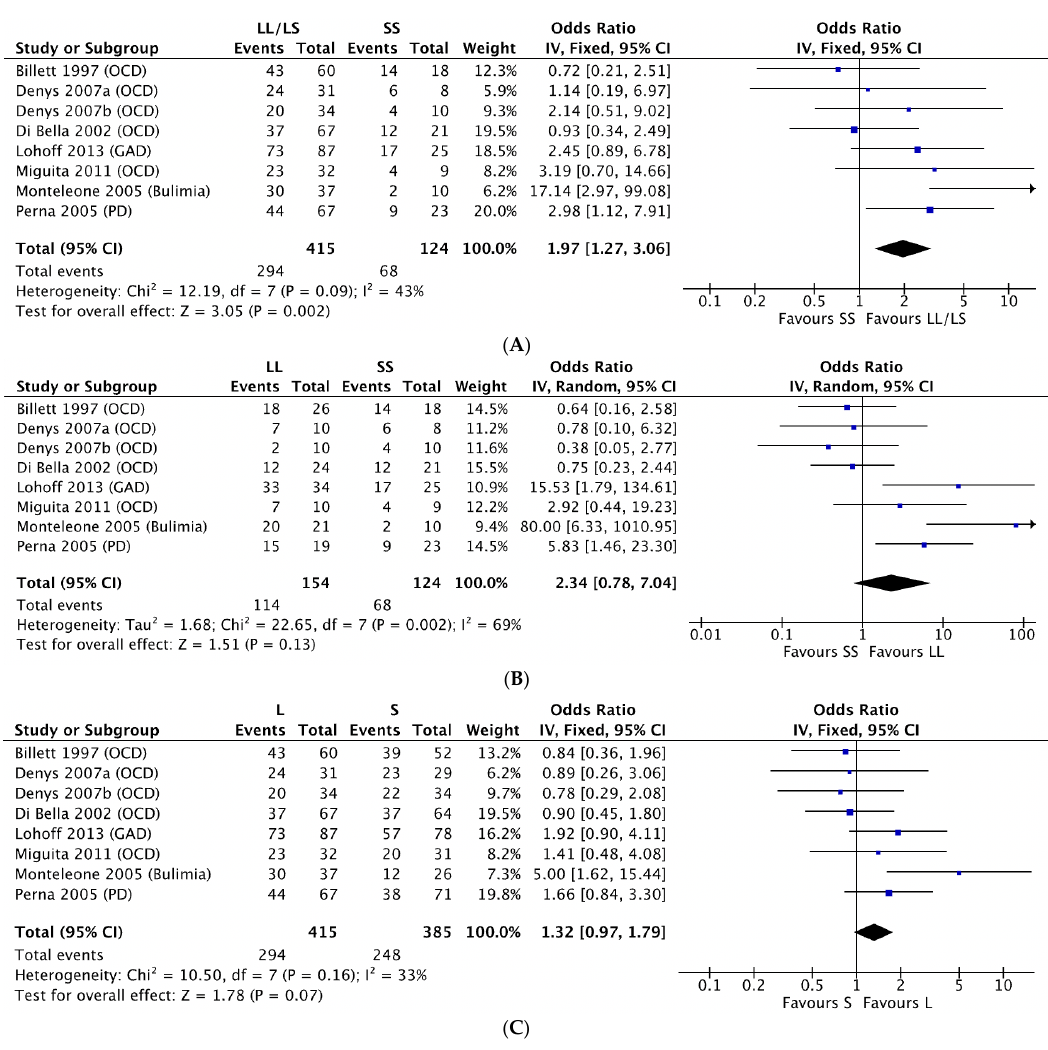
Table 3. Characteristics of studies (n = 11) included in the meta-analysis on antidepressant tolerability.